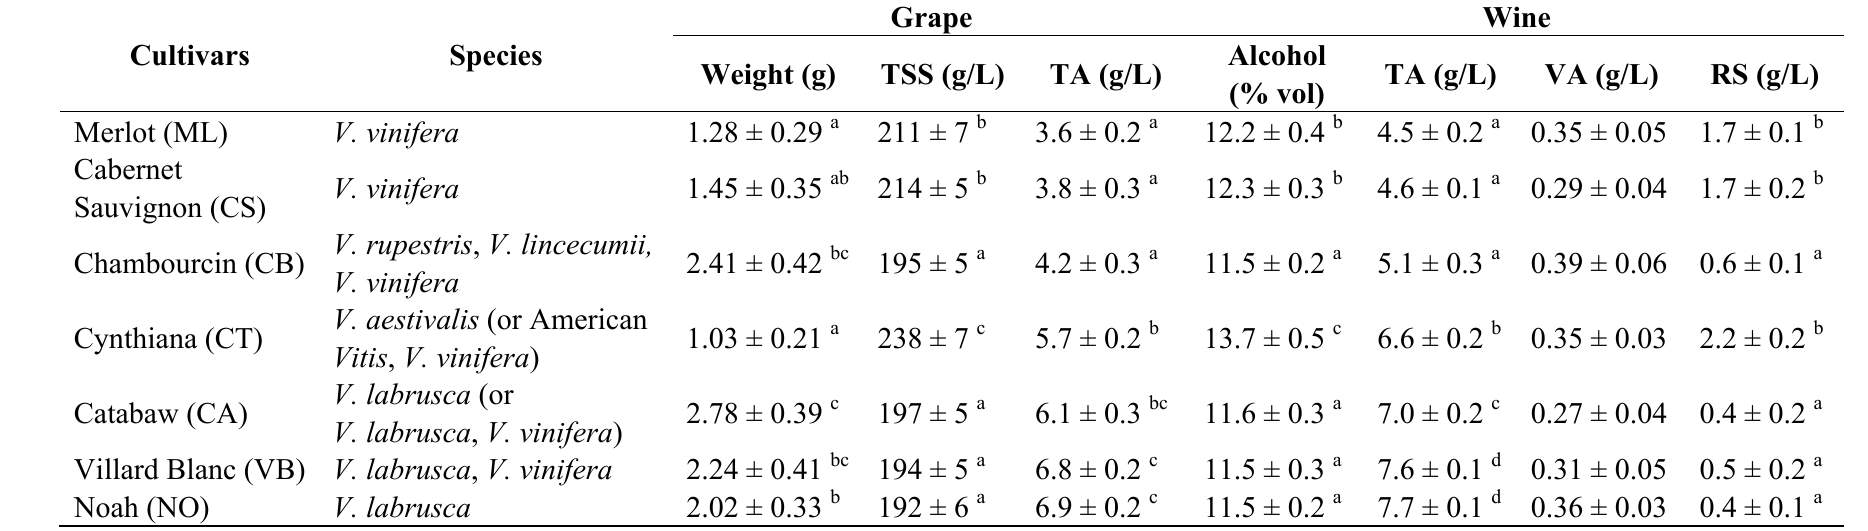
Table 1. The general characteristics of berries and wines of different grape cultivars.